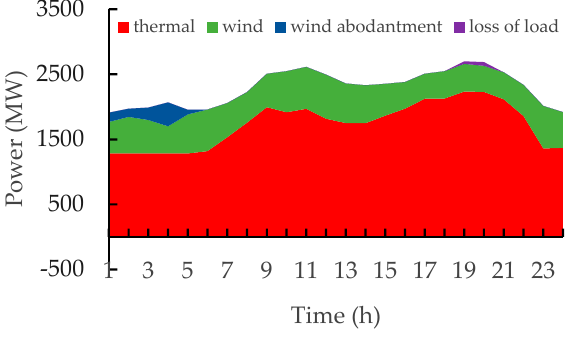
Figure 4. Scheduling plan of Case 1.